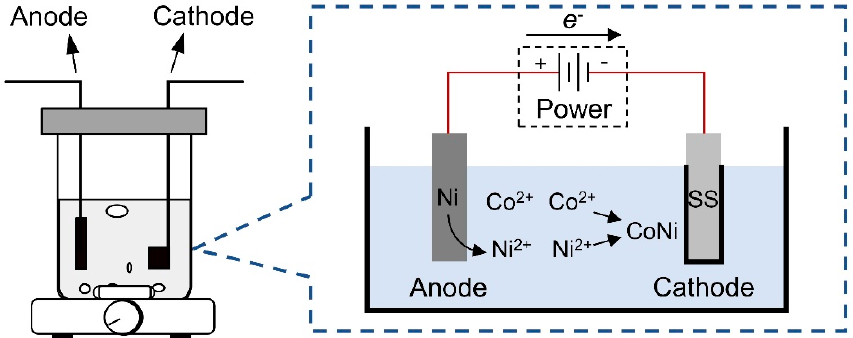
Figure 1. Schematic diagrams of the device and principle of electrodeposition of Ni–Co coating.